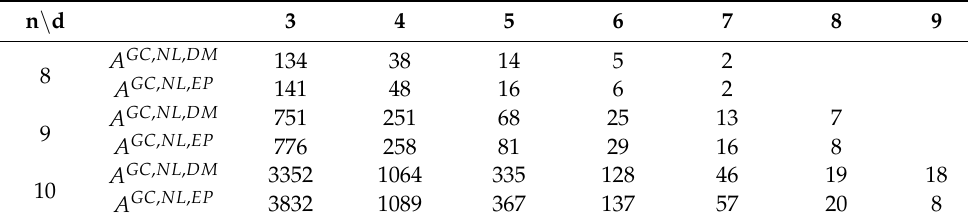
Table 11. Comparison results for the hairpin structure number.